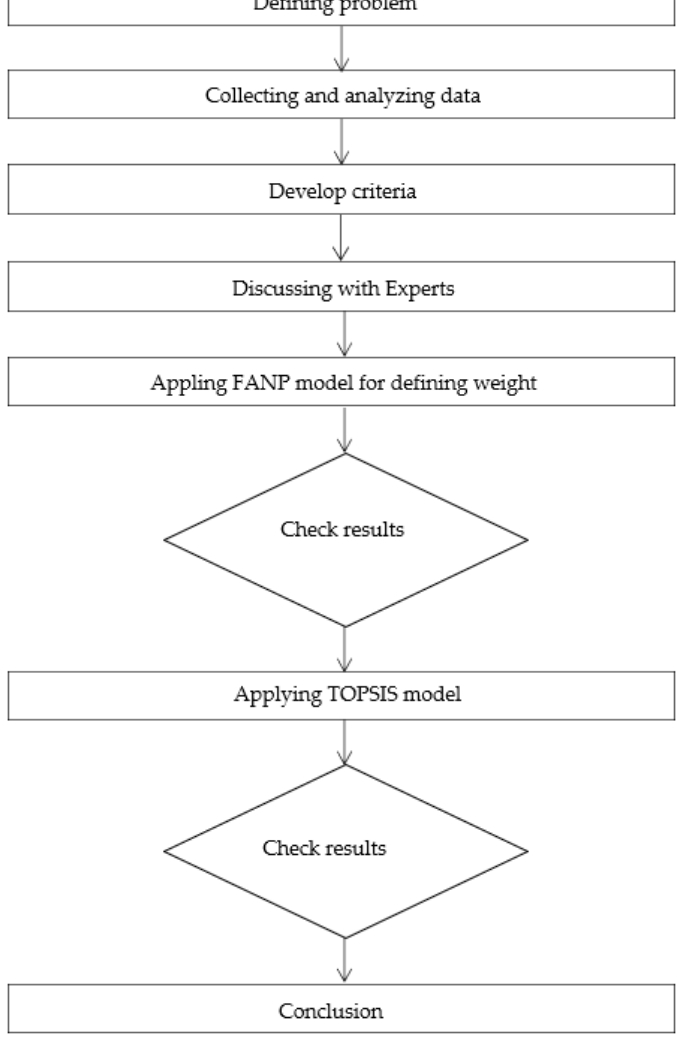
Figure 2. Research graph.